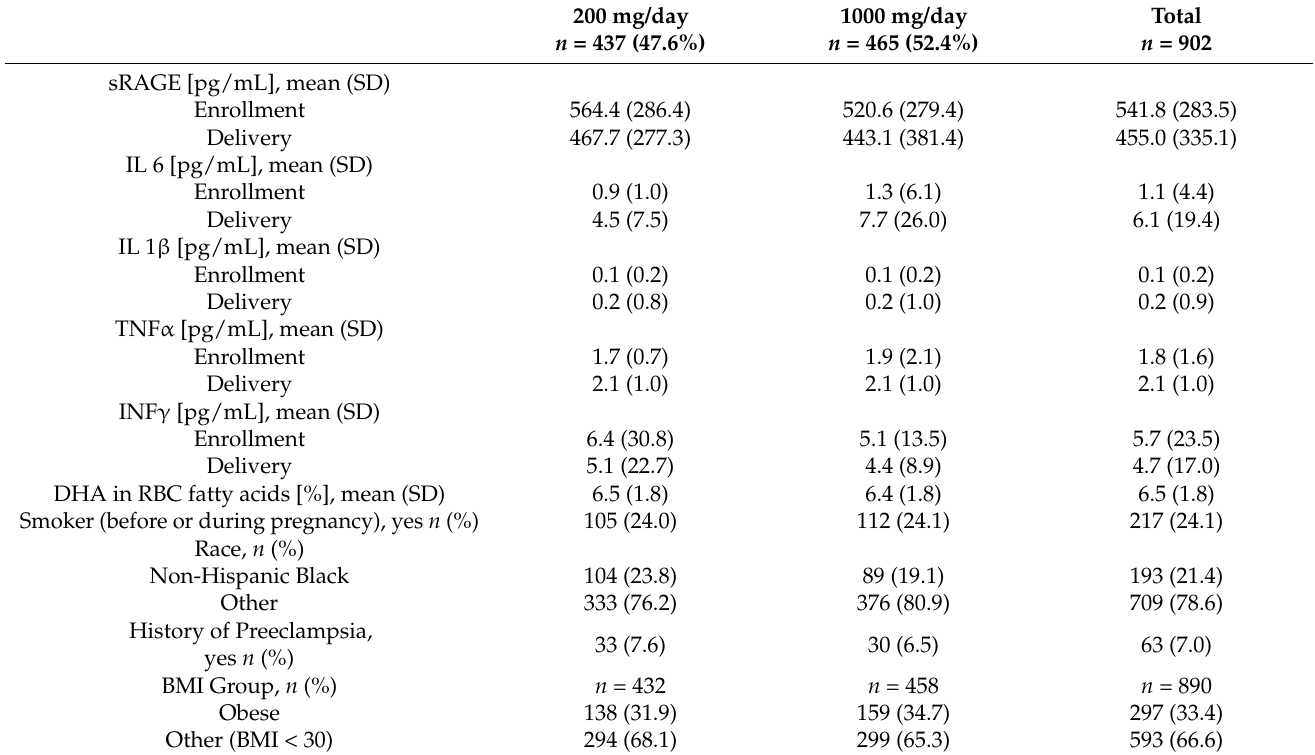
Table 1. Descriptive Summary of